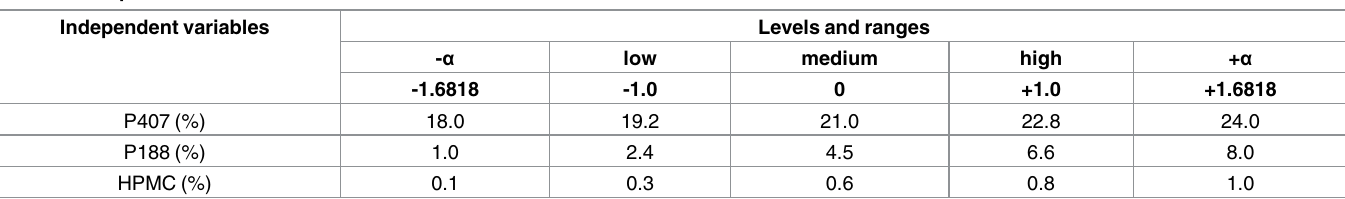
Table 3. Independent variables and natural levels. Independent variables